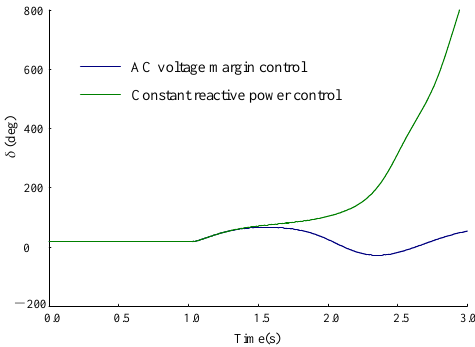
Figure 6 . Generator angles after AC system fault under different VSC-HVDC control modes. Figure 6. Generator angles after AC system fault under di ff erent VSC-HVDC control